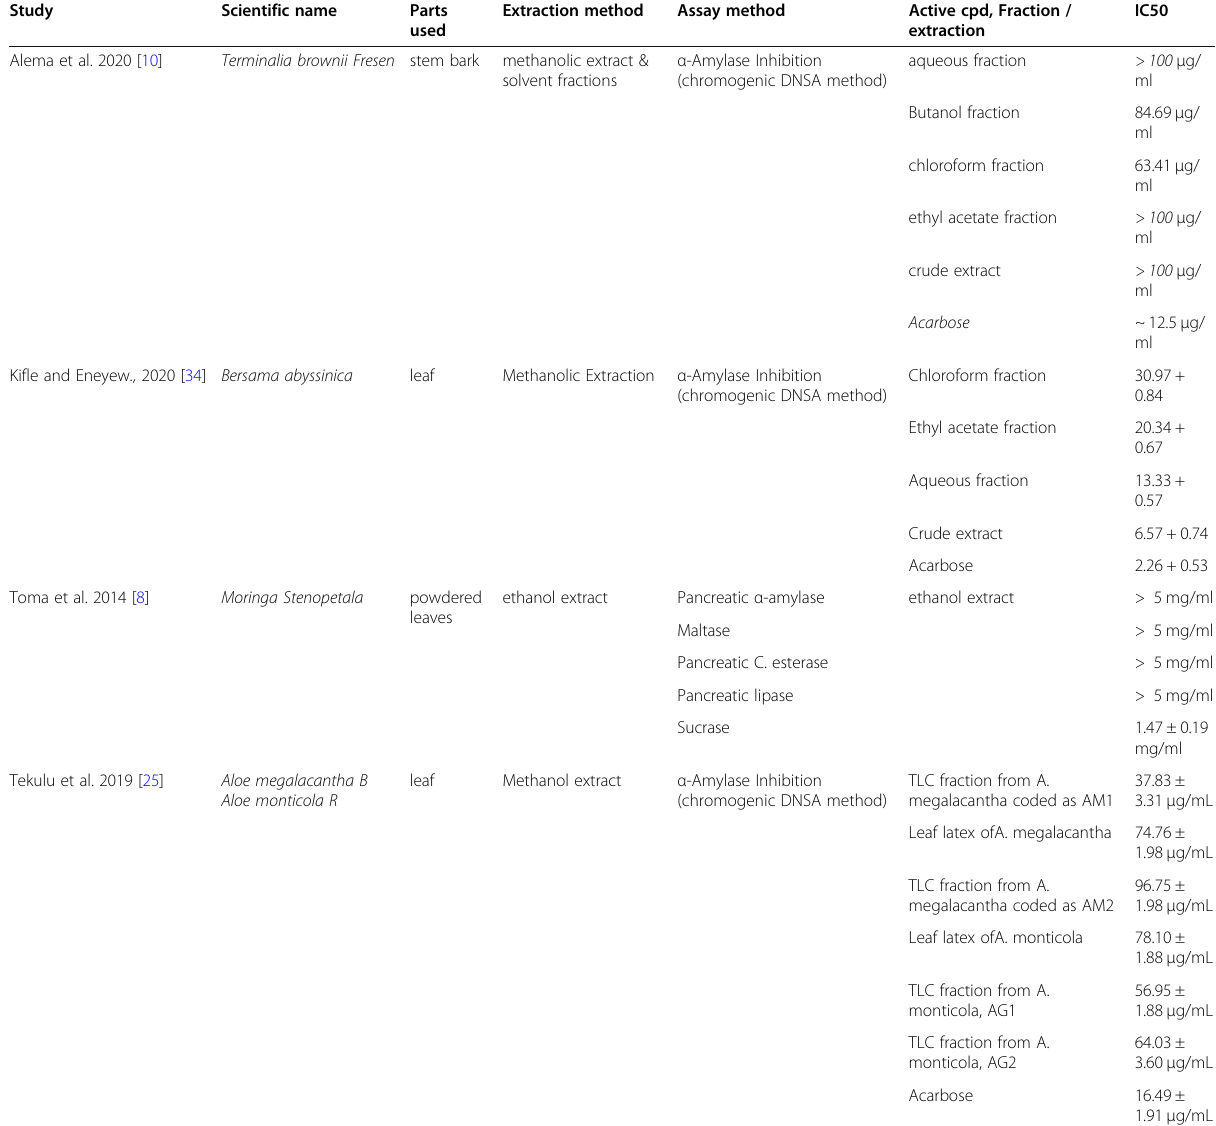
Table 2 In vitro anti-diabetic activity of medicinal plants in Ethiopia Study Scientific